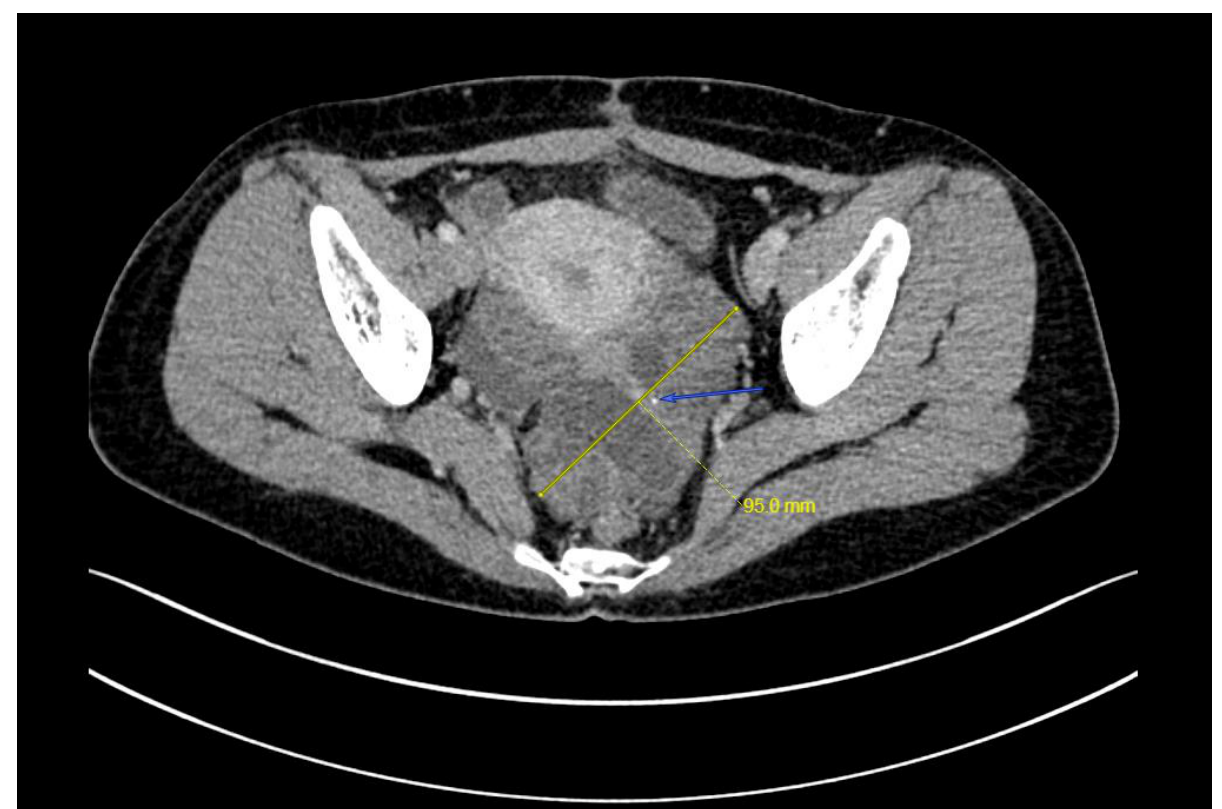
Figure 3. A 9.5 × 6.2 cm mass was noted left posterior of the uterus with an enhancement of solid component but not cystic component, no enlarged retroperitoneal lymph node was noted (arrow,